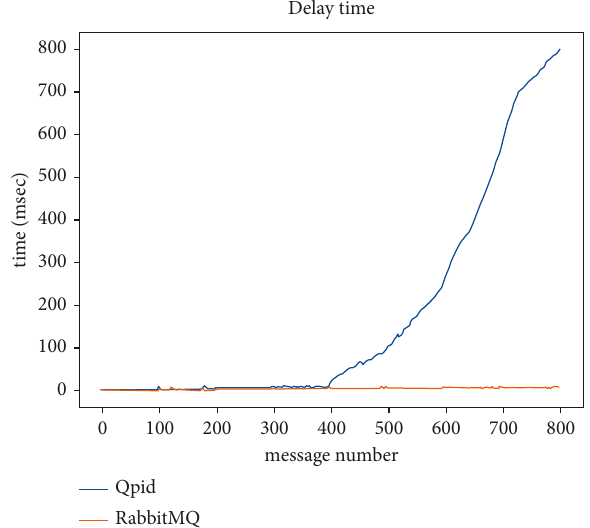
of increasing the payload size every 100